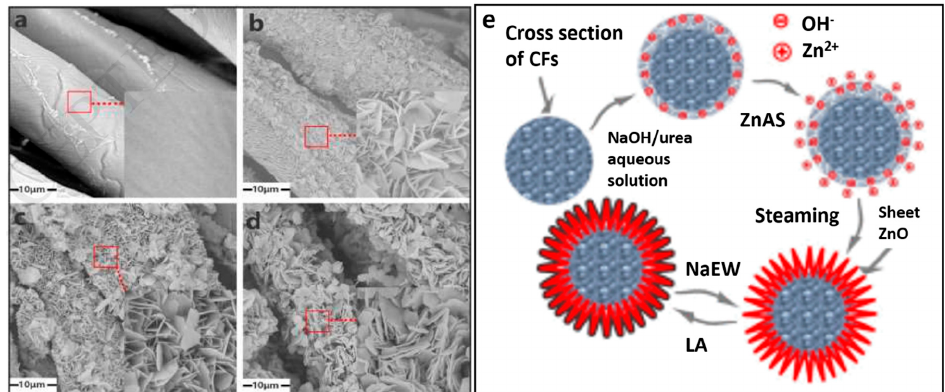
Figure 7. ( a ) unmodified, ( b ) ZnO modified, ( c ) ZnO-lauric acid modified, ( d ) ZnO-lauric acid-sodium hydroxide and ethyl alcohol aqueous solution modified cellulose fabric fibers and ( e ) diagrammatic representation of functionalization of reversible superhydrophobic/superhydrophilic cellulose fabric fiber. (NaEW—sodium hydroxide ethyl alcohol aqueous solution, LA—lauric acid). Reproduced with permission from Fan et al . [55]. Elsevier copyright © 2016.